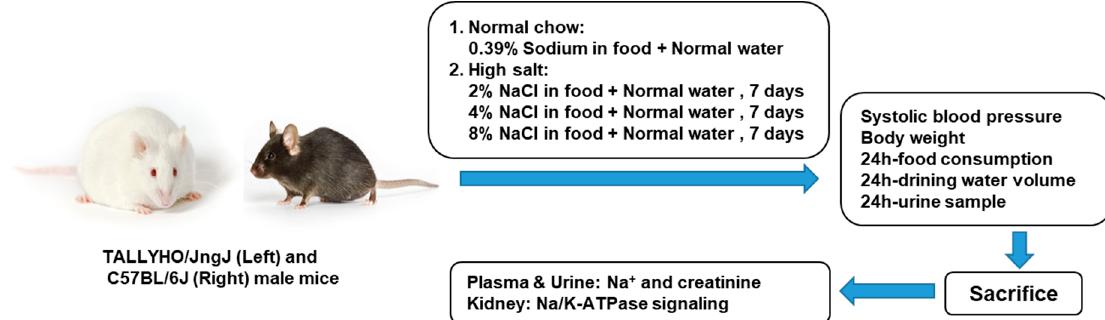
Figure 6. Experimental protocol. Aged-matched male obese TALLYHO/JngJ (TH) and wild-type C57BL/6J (B6) mice were divided into two groups. (1) Normal chow group: 0.39% sodium in chow; (2) High salt group: 7 days of 2% NaCl in food, 7 days of 4% NaCl in food, and then 7 days of 8% NaCl in food.